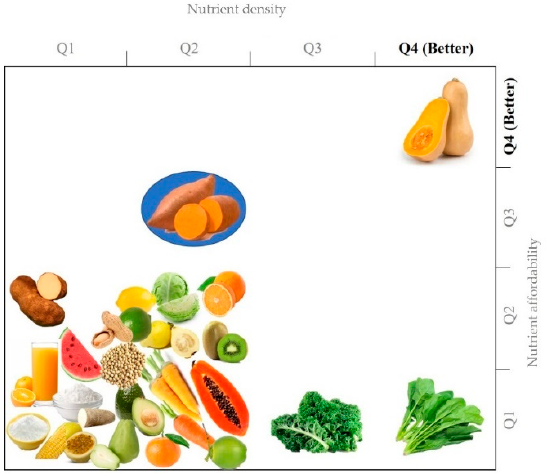
Figure 2. Nutrient density and affordability of SP-based foods as compared to common fruits and vegetables. Nutrient density ( Nutrient Rich Foods index (NRF9.3), see references 60 and 61 for calcu- lation details) vs. nutrient affordability (NRF9.3.price − 1 ·100 kcal − 1 ; higher (Q1) to lower (Q2) cost) plot.